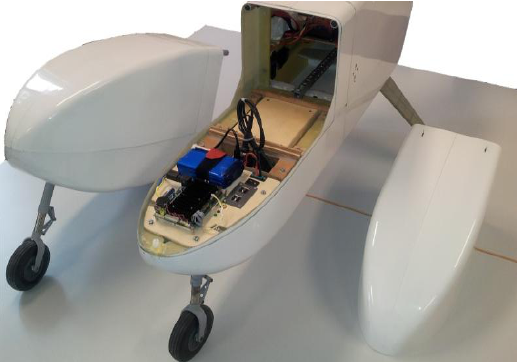
Figure 2. ALADINA sensor